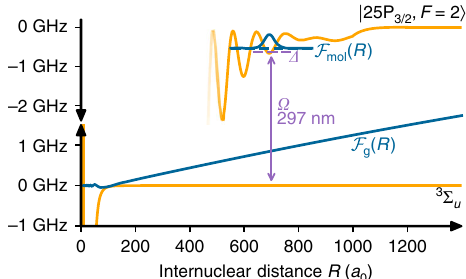
Fig. 2 Collapse and revival measurements. After a variable hold time τ in the optical lattice, time-of- fl ight images of the cloud are taken and the Fig. 1 Schematics of the Rydberg optical Feshbach resonance. Two 87 Rb visibility of the interference pattern is extracted (see Methods). The blue atoms trapped in a 3D optical lattice scatter in the 3 Σ u channel and are data correspond to an uncoupled system, the red data to a detuning of Δ = coupled with Rabi frequency Ω and detuning Δ close to the − 2 π × 12 MHz and the yellow data to Δ = 2 π × 18 MHz (both with atomic photoassociation resonance of an ultra-long-range Rydberg molecule in the Rabi frequency 2 π × 810 kHz). If not otherwise stated all measurements are so-called deep potential, which is adiabatically connected to the ; F ¼ 2 state. The blue lines denote the relative wave function of the taken with a fi nal lattice depth of 30 E rec (recoil energy). An increased 25 P 3 = 2 ð R Þ and the molecular wave function F ð R Þ . two ground-state atoms F (decreased) oscillation frequency and thus interaction strength can be seen g mol for blue (red) detuning. For each hold time we typically record six Due to the large size of the Rydberg molecule, the coupling takes place at a independent measurements. The error bars denote the statistical error from very large internuclear distance, making it independent of the short-range ð R Þ for R < 100 a averaging individual physics of the open channel (small oscillations of F 0 ) g